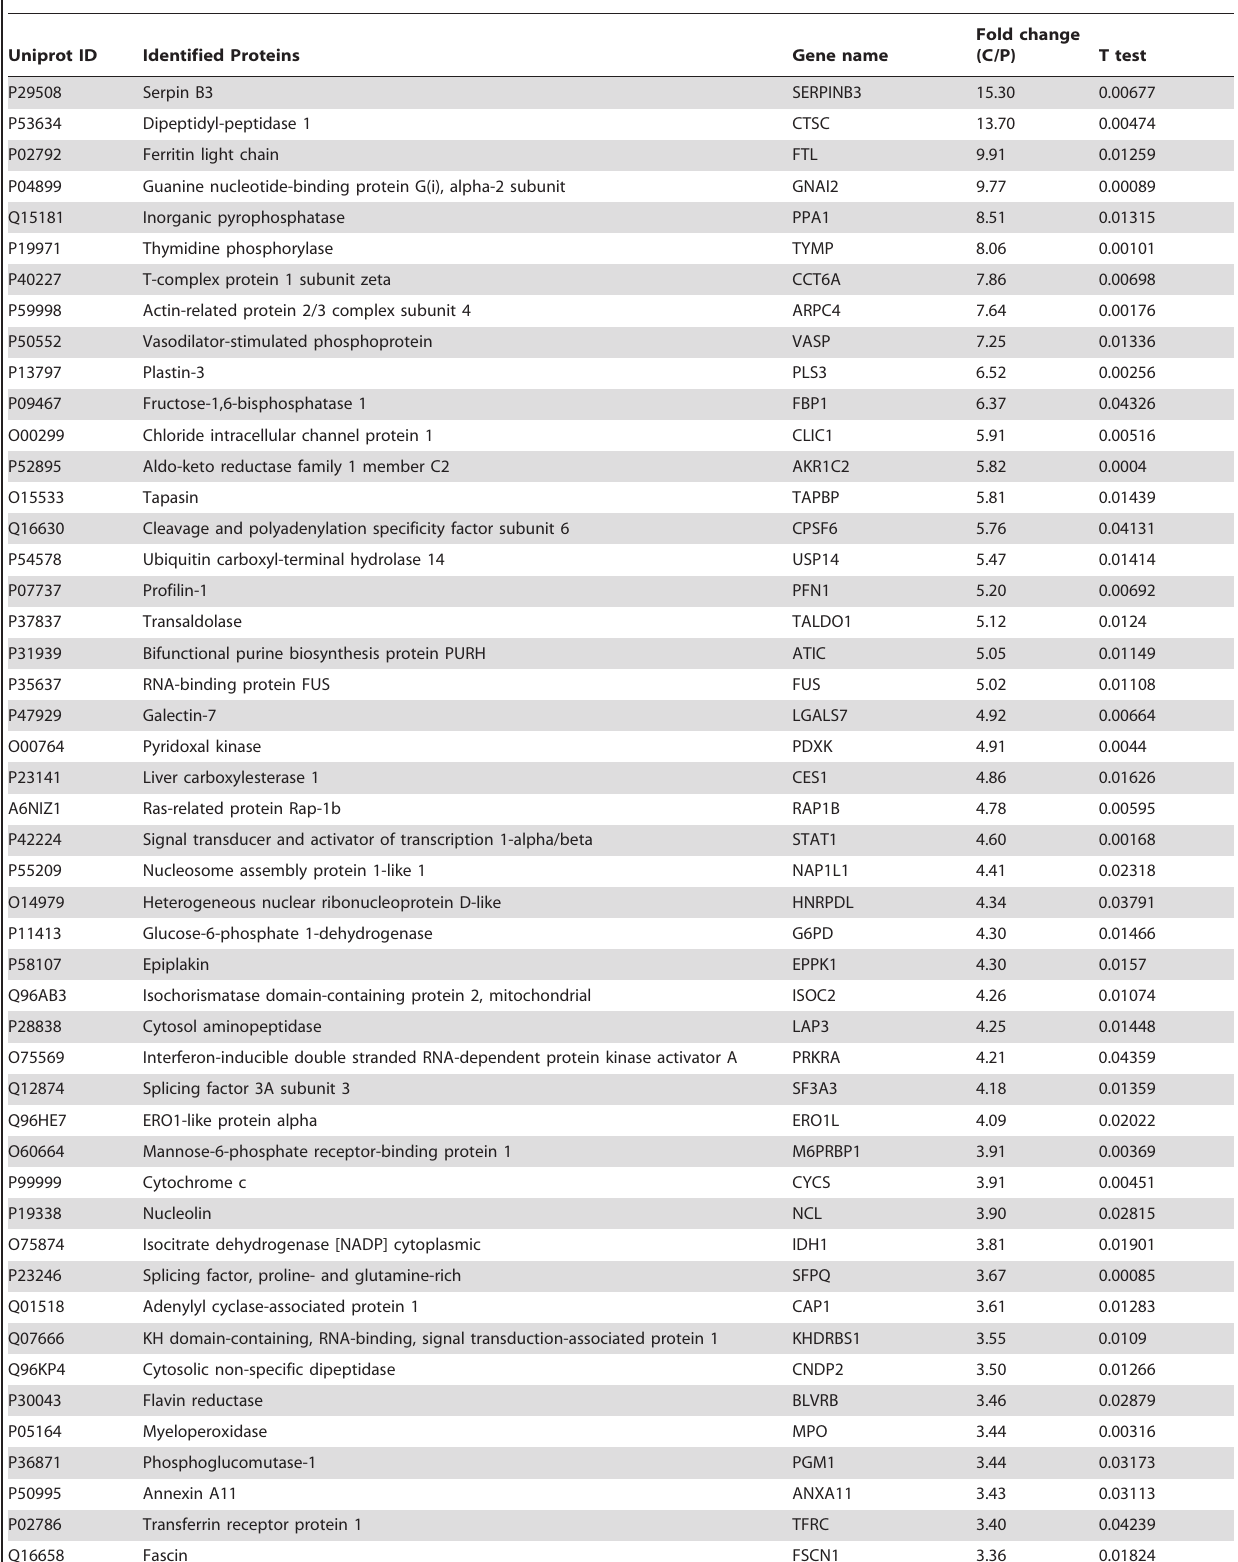
Table 2. Differentially expressed proteins screened out compared the laryngeal carcinoma tissues (C) with the corresponding adjacent noncancerous tissues